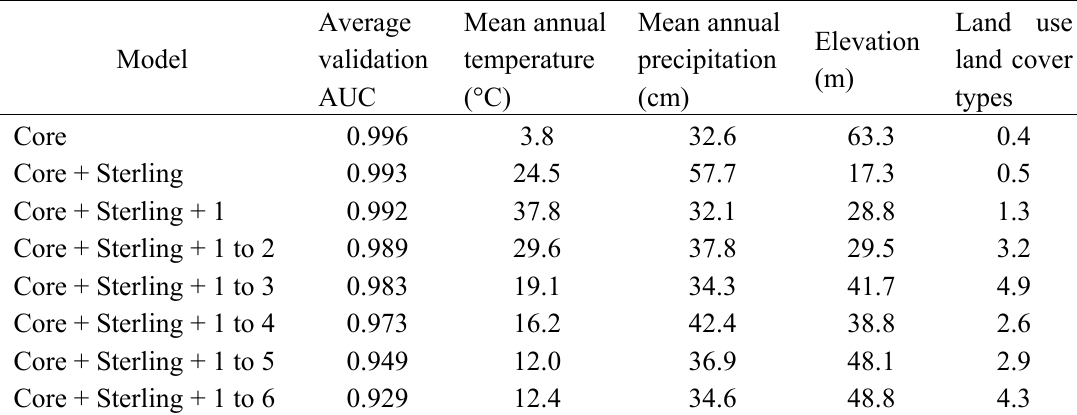
Table 1. Maxent model results and the percent contribution of environmental variables. AUC is area under the ROC (receiver operating characteristic) curve.